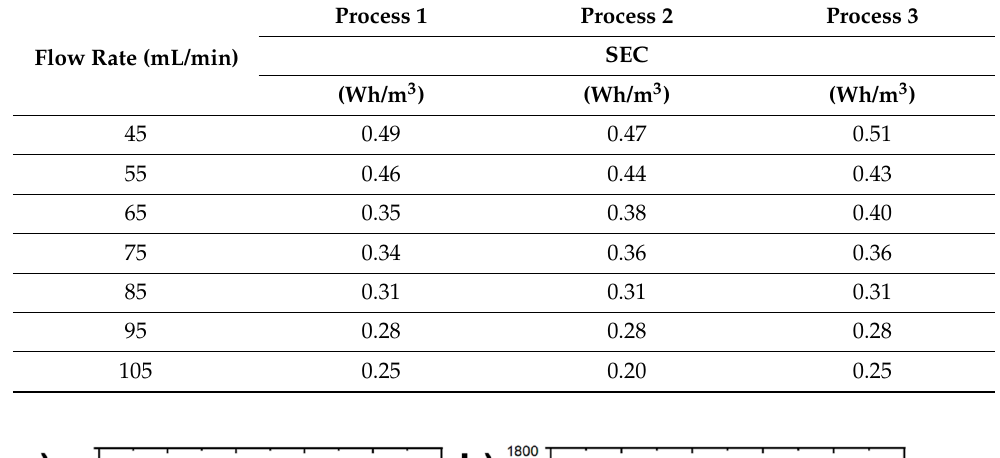
Table 4. Specific energy consumption ( SEC ) variation as a function of flow rate for the three sorts of the process (NaCl 0.4 M, 1.2 V).